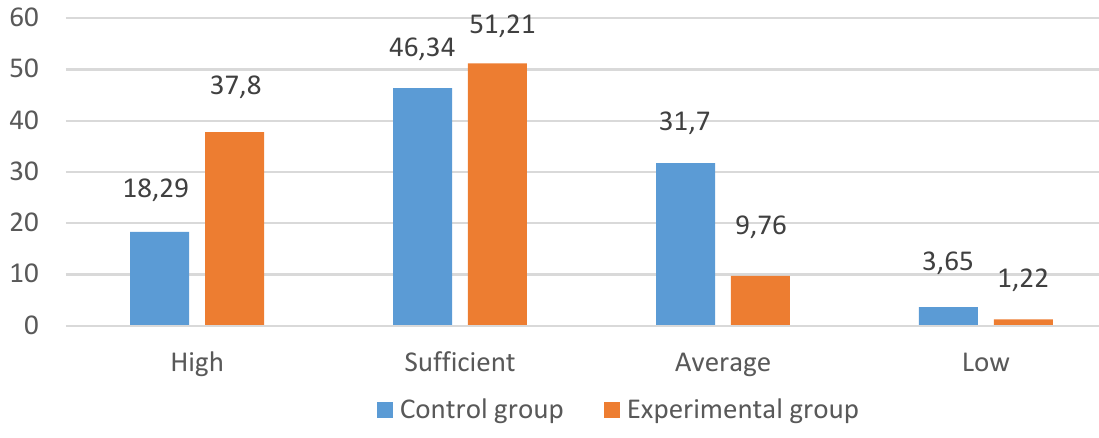
Figure 2. Distribution of control group and experimental group students according to the levels of penitentiary manager’s professional competence formedness after the experiment,